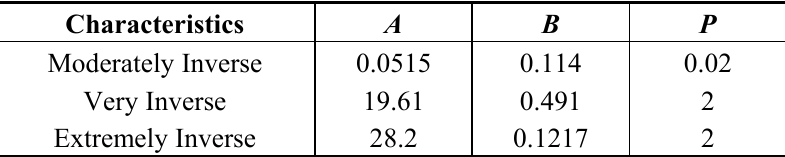
Table A1. Constants and exponents for standard